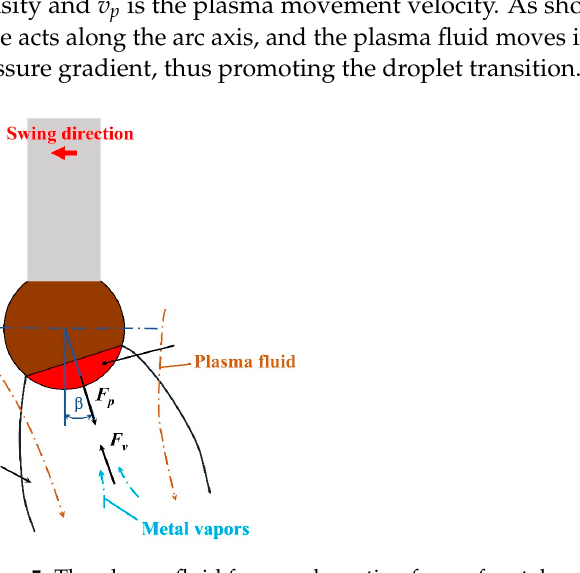
under the action of the radial electromagnetic force, thus promoting the droplet transition